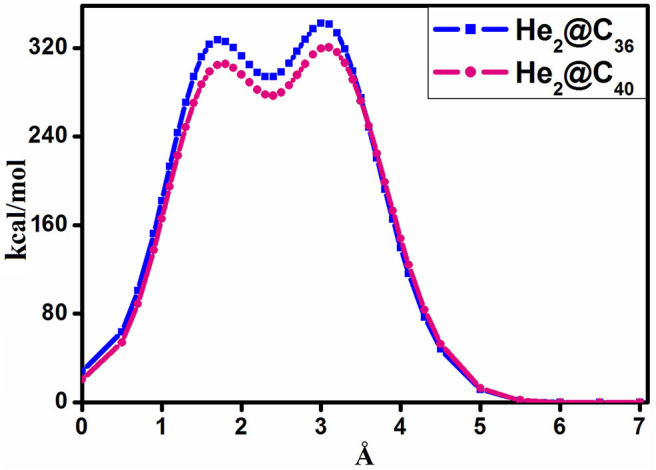
Boundary-crossing barrier of He2@CX (X = 36, 40).